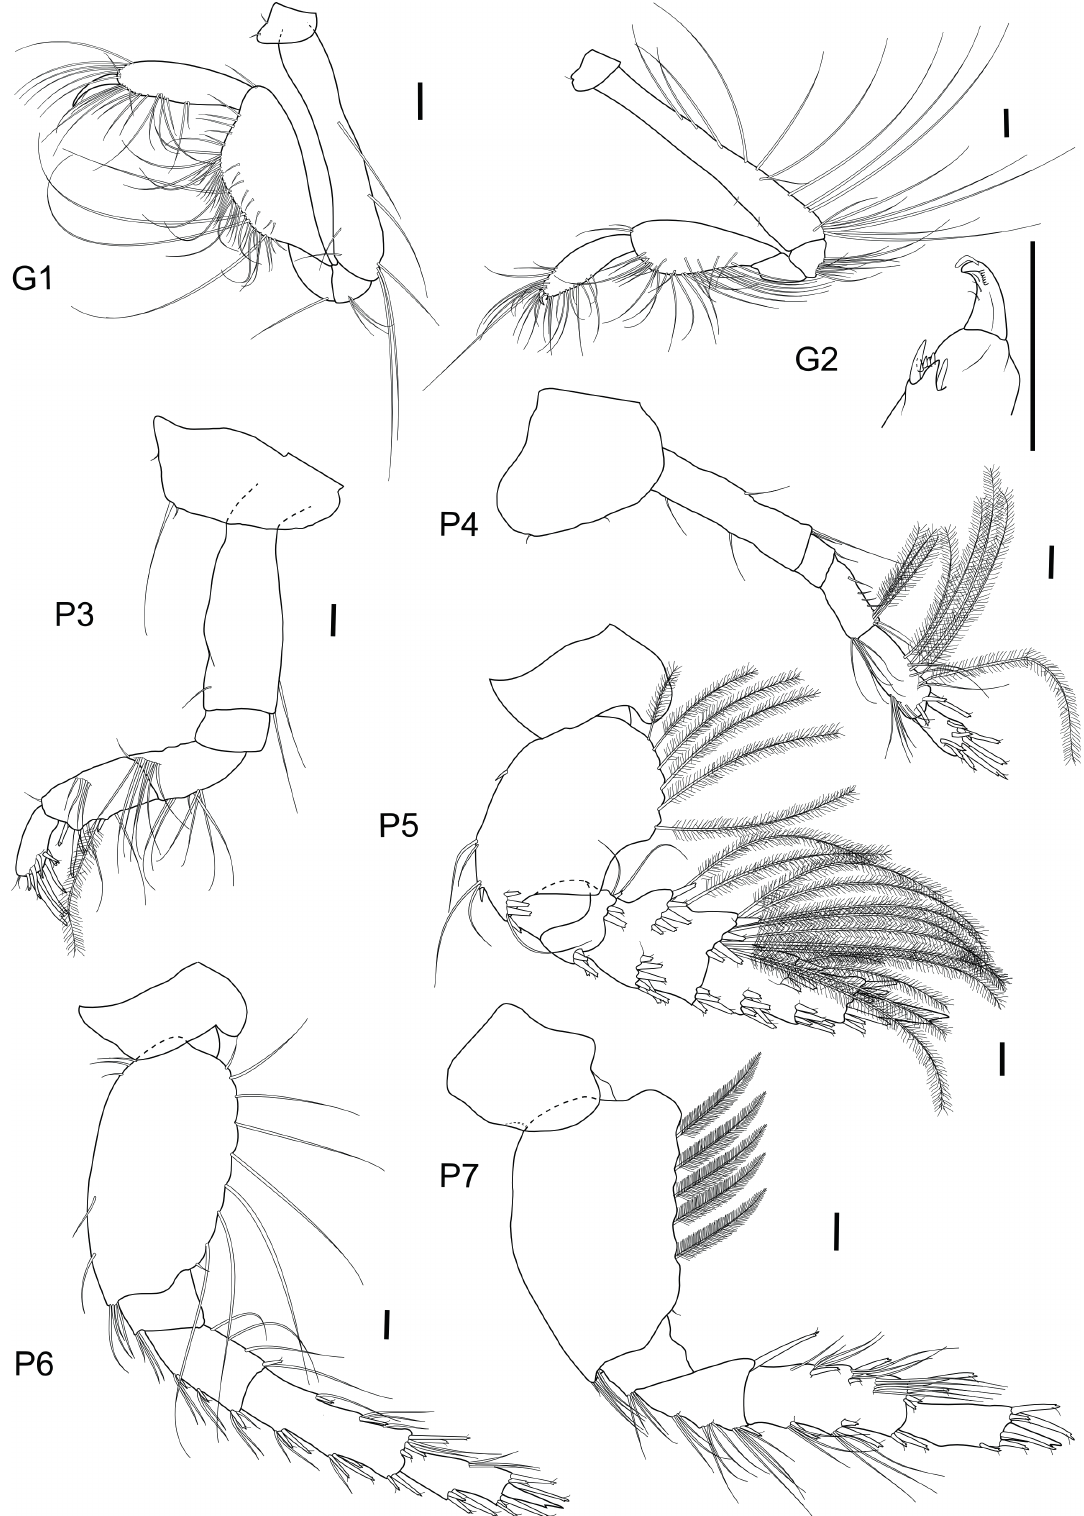
Figure 14 - Puelche mourae sp. nov. Female, 4.0 mm, MNRJ 28795: gnathopods and pereopods. Scales = 0.1